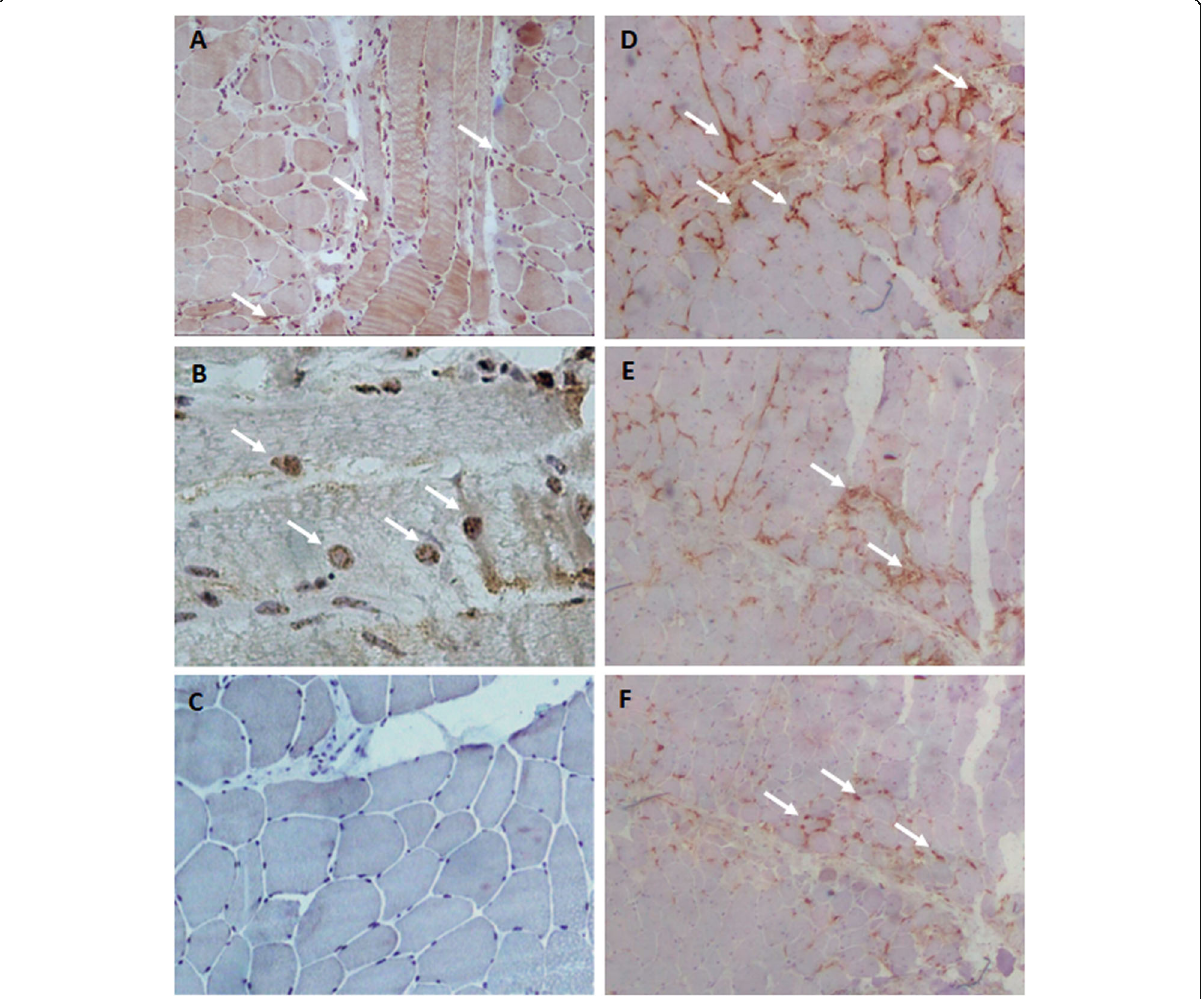
Fig. 2 Expression of YKL-40 in a muscle specimen from a patient with antisynthetase syndrome. Positive immunohistochemistry reaction of ( A ) YKL-40, ( B ) YKL-40*; ( D ) CD68, ( E ) CD4, and ( F ) CD8. Magnification is 200x or 400x*. As a negative control of YKL-40 ( C ), a specimen from a patient with antisynthetase syndrome, but without infiltrate